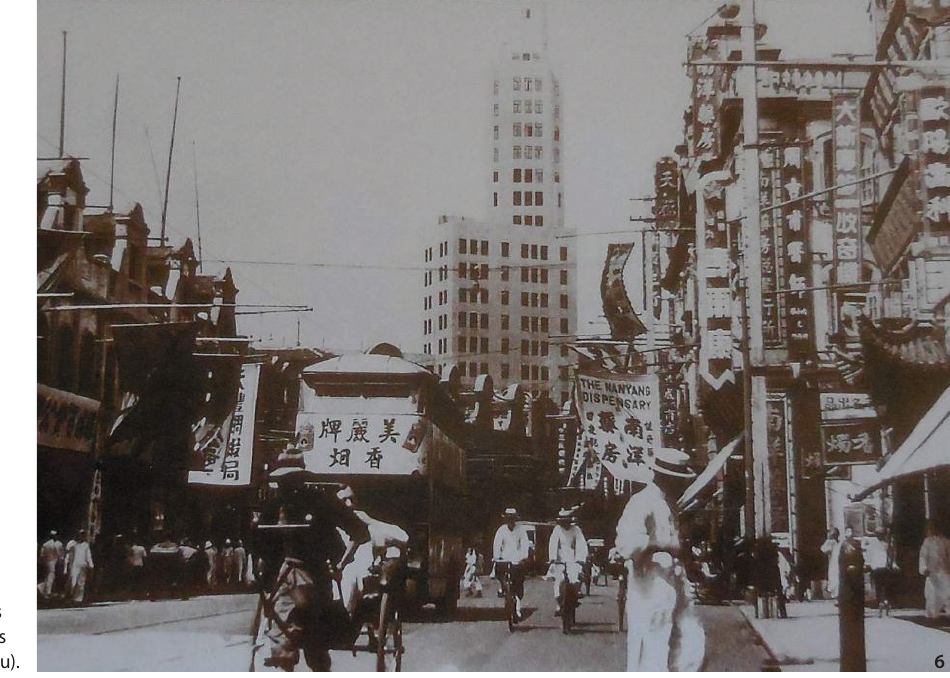
Figure 6 Wing On Department Store, Art Deco Tower, architects Elliot Hazard and Edward Phillips (Source: Peter Hack on abc.net.au).